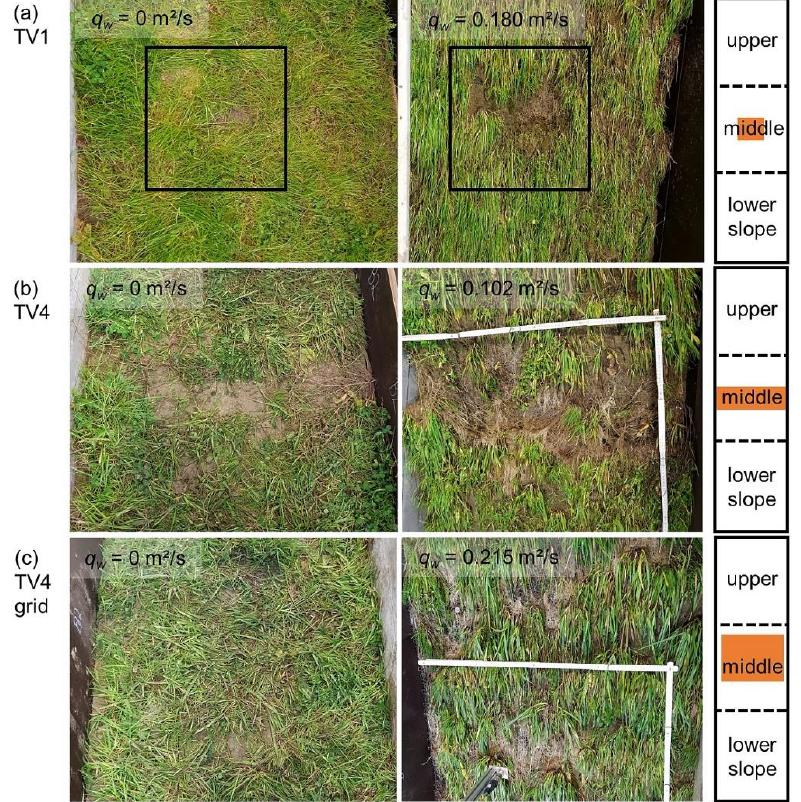
Figure 9. Cont. Figure 9.